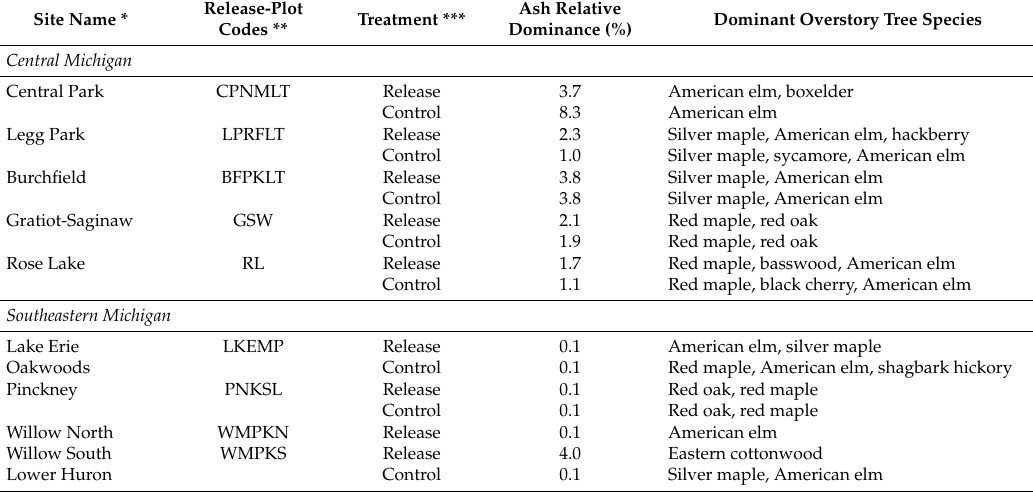
Table A1. Dominant overstory vegetation at study sites in central and southeastern Michigan. Ash relative dominance was measured at the time of sampling (i.e., after EAB-caused ash mortality